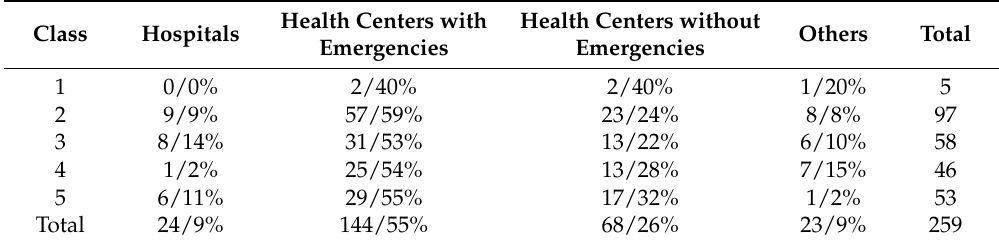
Table 7. Administrative classification breakdown of the